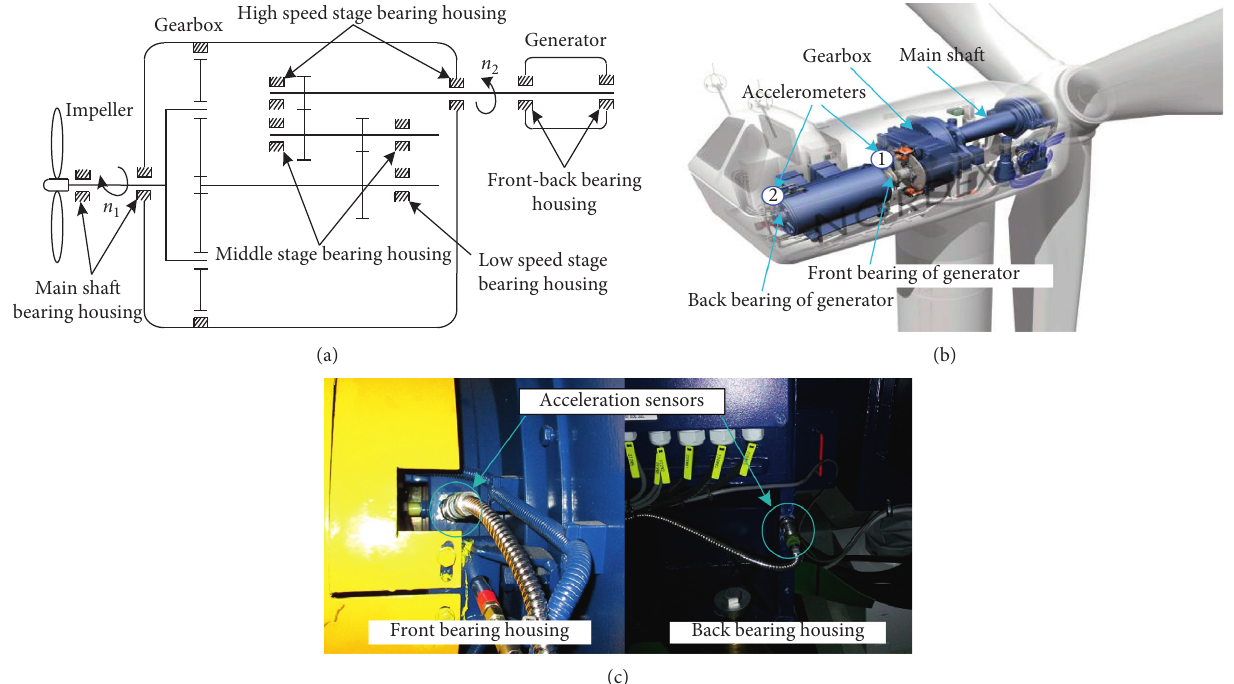
Figure 19: (a) The schematic diagram of the wind turbine. (b) The visualization of sensor placement. (c) The installed acceleration sensors on the front-back bearing housings of the generator.